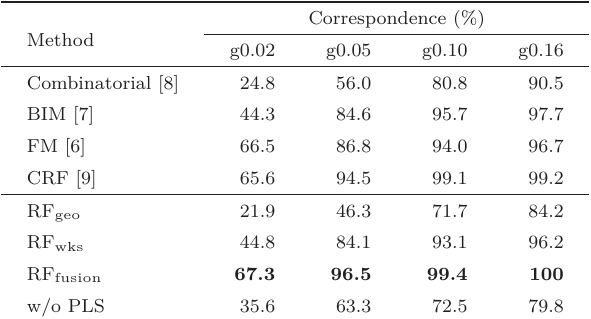
Table 1 Comparison of pairwise correspondences by the proposed method with and without PLS regularization, and combinatorial [8], FM [6], BIM [7], and CRF [9] methods on the TOSCA dataset